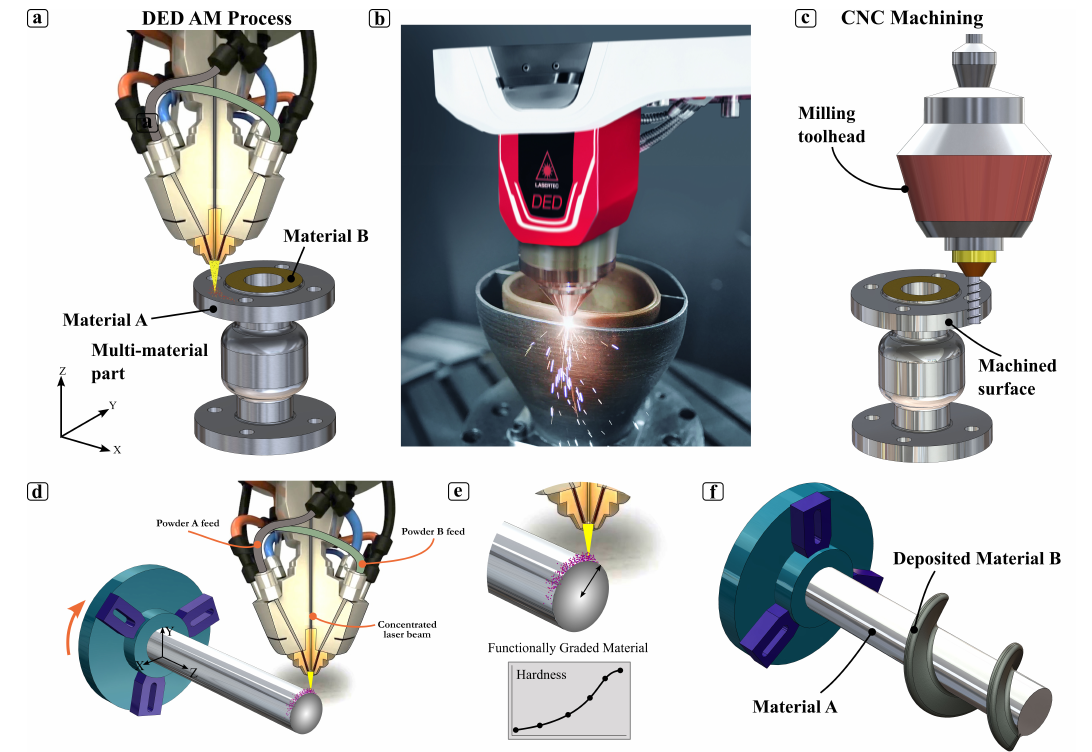
Figure 11. Hybrid AM system which combines DED and CNC machining processes: ( a ) fabrication of multi-material part with the help of DED process, ( b ) multi-material heat exchanger fabricated by Lasertec 125 by DMG MORI, reproduced with permission, Copyright © 2021 [96], ( c ) CNC machining process to increase the surface quality of the part, ( d ) performing DED process on the shaft to fabricate functionally graded material, ( e ) FGM-fabricated part with various hardness properties, ( f ) deposition of second material during turning